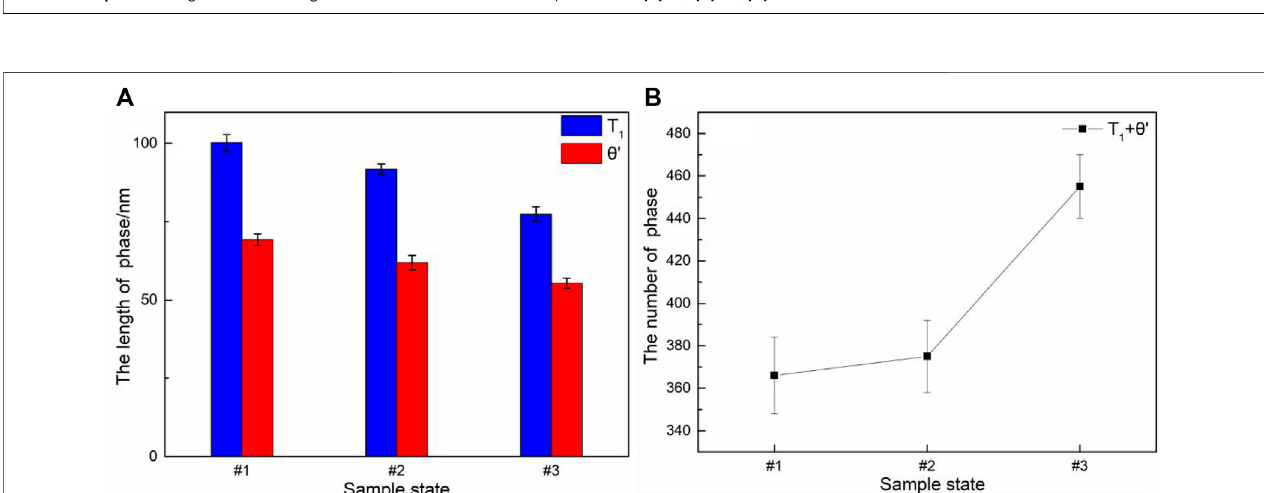
FIGURE 8 | STEM diagram taken along < 110 > Al direction of the sample at T83. (A) 1#, (B) 2#, (C) 3#.